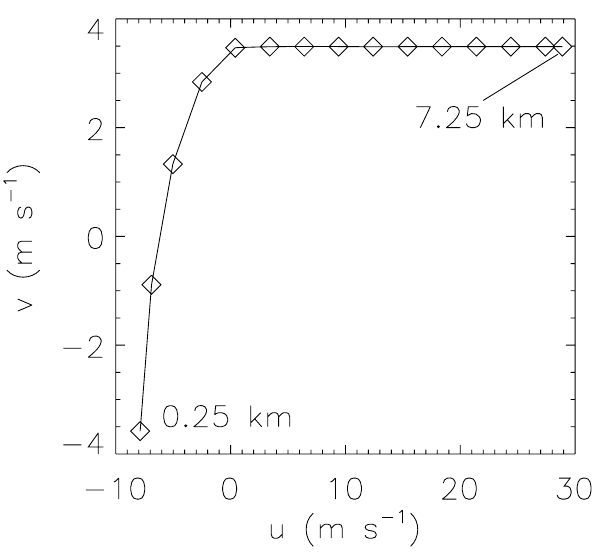
Fig. 2. Hodograph indicating u and v winds of the initial envi- ronment. Diamonds represent winds at 0.5km intervals between heights of 0.25 and